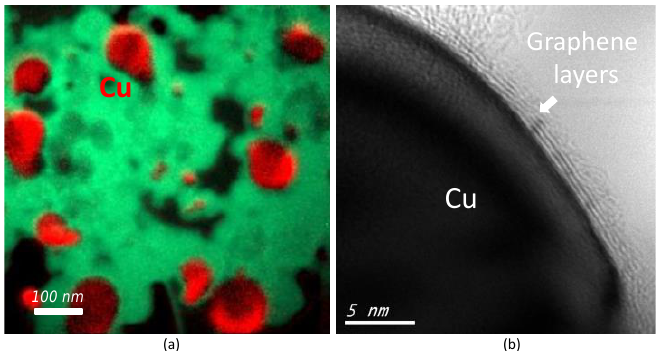
Figure 3. TEM image of multilayered graphene sheets in (Gr) sample. Produced by DC arc-discharge (scale bar 20 nm).